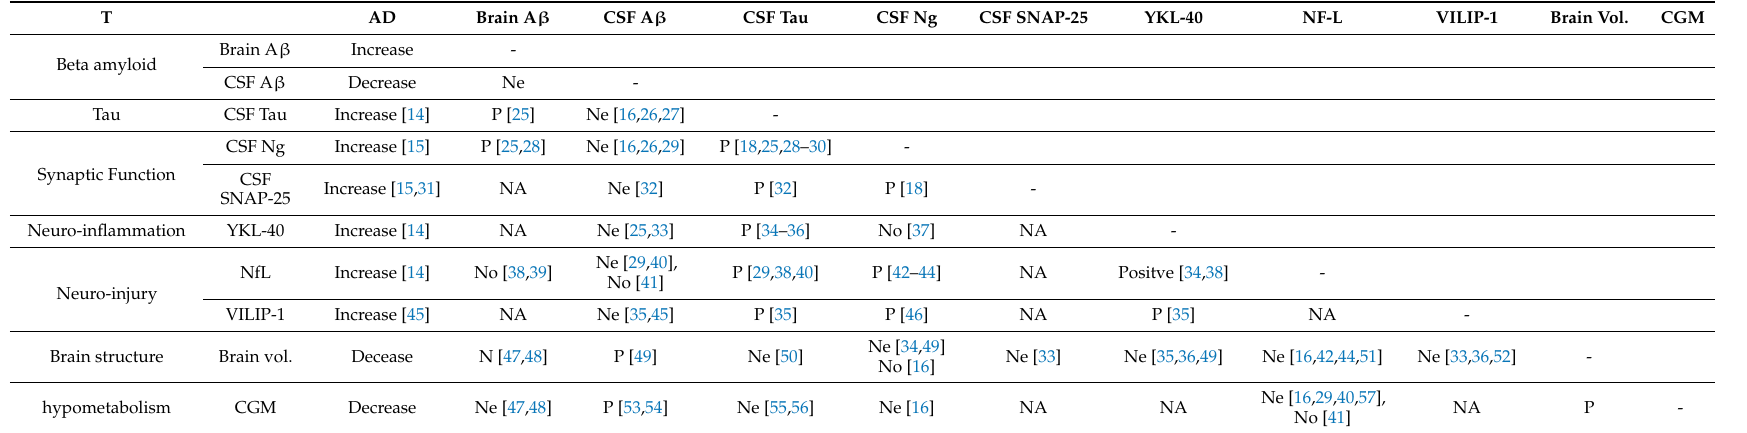
Table 1. Association among the biomarkers at